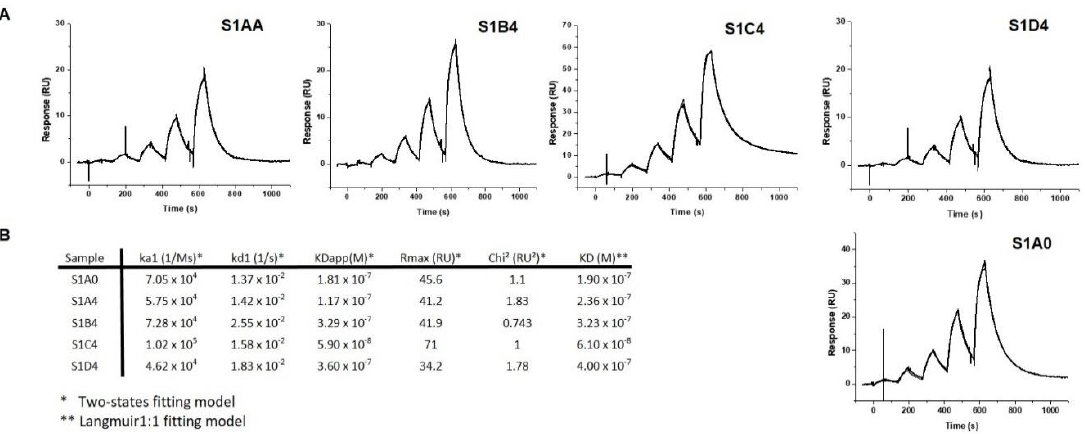
Figure 7. A ffi nity binding analysis by surface plasmon resonance (SPR) of purified scFvs on immobilized Surface Antigen-1 (SAG1). ( A ) Single cycle kinetic titrations (600-200-66-22-7.5 nM) of scFvs on immobilized SAG1. The thin-lined curves represent fitting by two state fitting model. ( B ) SPR analyses of binding kinetic parameters.